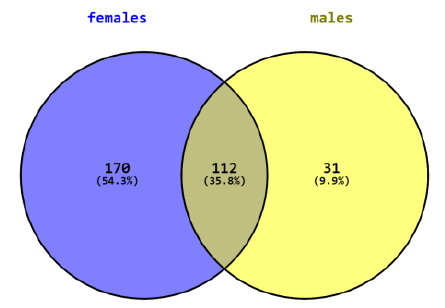
Figure 2. Number of genes di ff erently expressed in males, females, and both sexes.